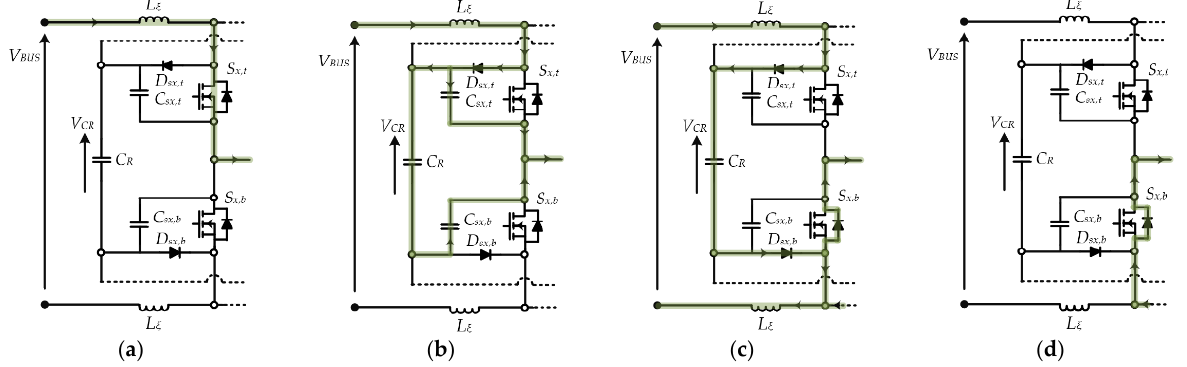
Figure 6. Current path highlighted in green during the turn-off of S x,t : ( a ) step 1, ( b ) step 2, ( c ) step 3, ( d ) step 4.